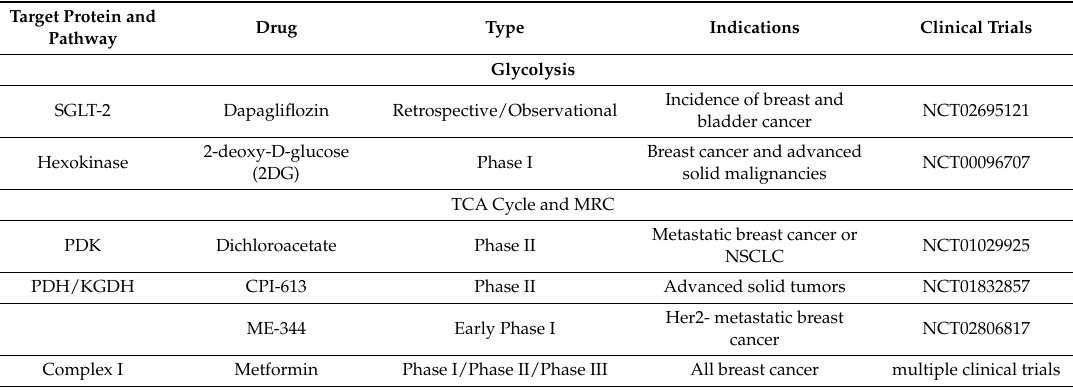
Table 2. Drugs currently in different stages of development as metabolic interventions in breast cancer Target Protein and